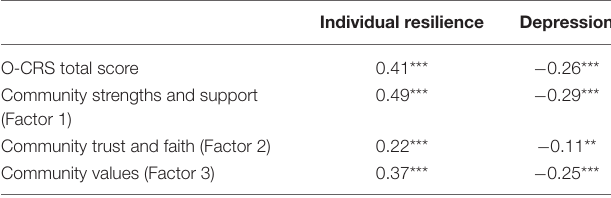
TABLE 4 | Correlations of resilience and the other scales ( N = 652; subsample